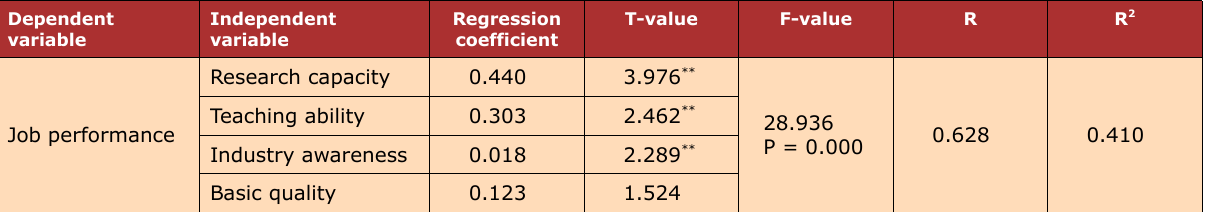
Table 2. Regression analysis on competency and job